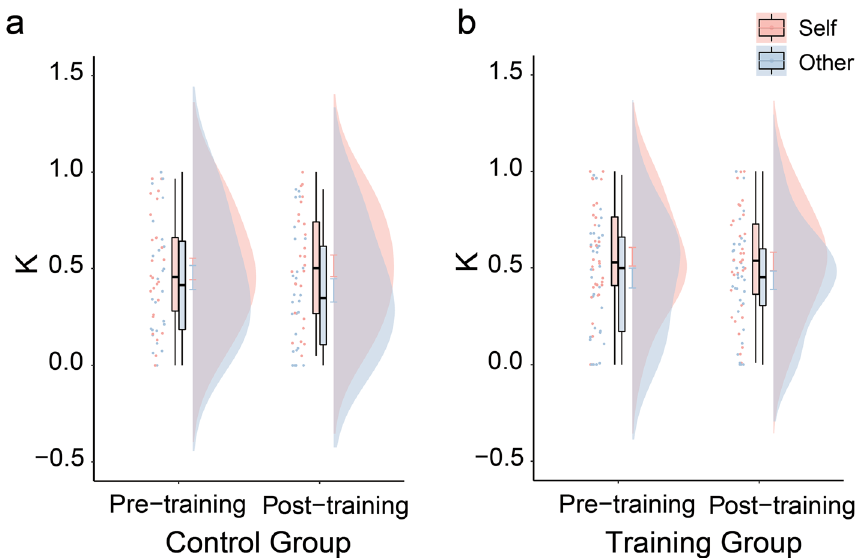
Figure 3. The harm aversion parameter depicted as a function of Session and Condition. ( a ) Control Group; ( b ) Training Group. Error bars on the distribution plots display standard errors of the means. Boxes display the interquartile range (IQR) between the 25th and 75th percentile. Horizontal lines inside the boxes indicate the